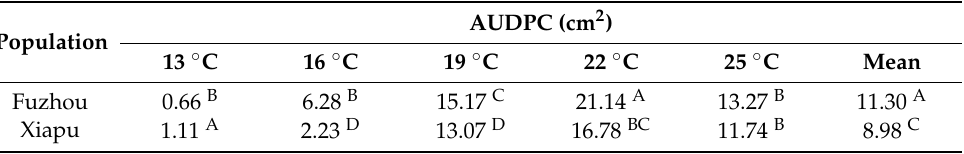
Table 1. Duncan’s multiple range test for differences in aggressiveness among the seven Phytophthora infestans populations. Aggressiveness, represented by AUDPC, was estimated from lesion sizes on potato leaves generated by isolates at 2–6 days